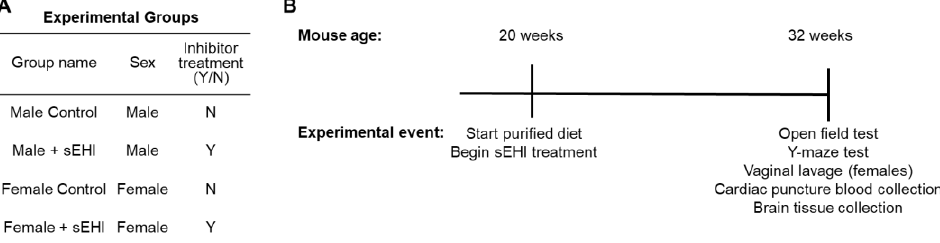
Figure 1. Experimental groups and study timeline: ( A ) Table of experimental groups detailing sex and inhibitor treatment. ( B ) Timeline of experimental procedures in relation to mouse age.